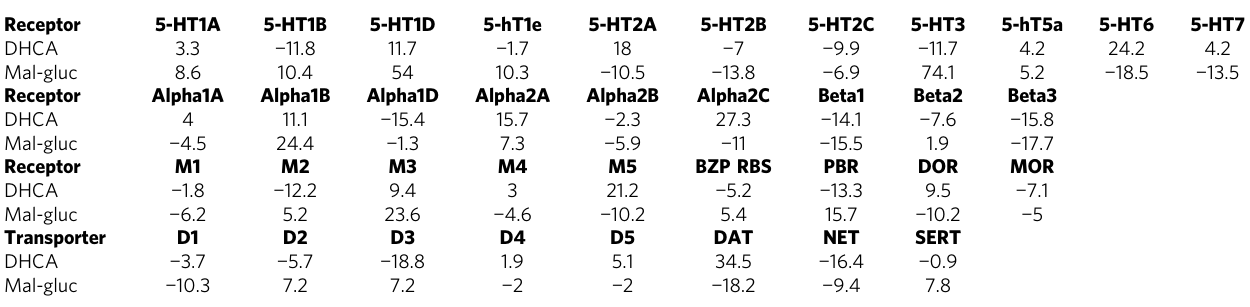
Table 2 Binding activities of DHCA and Mal-gluc with monoaminergic receptors and transporters